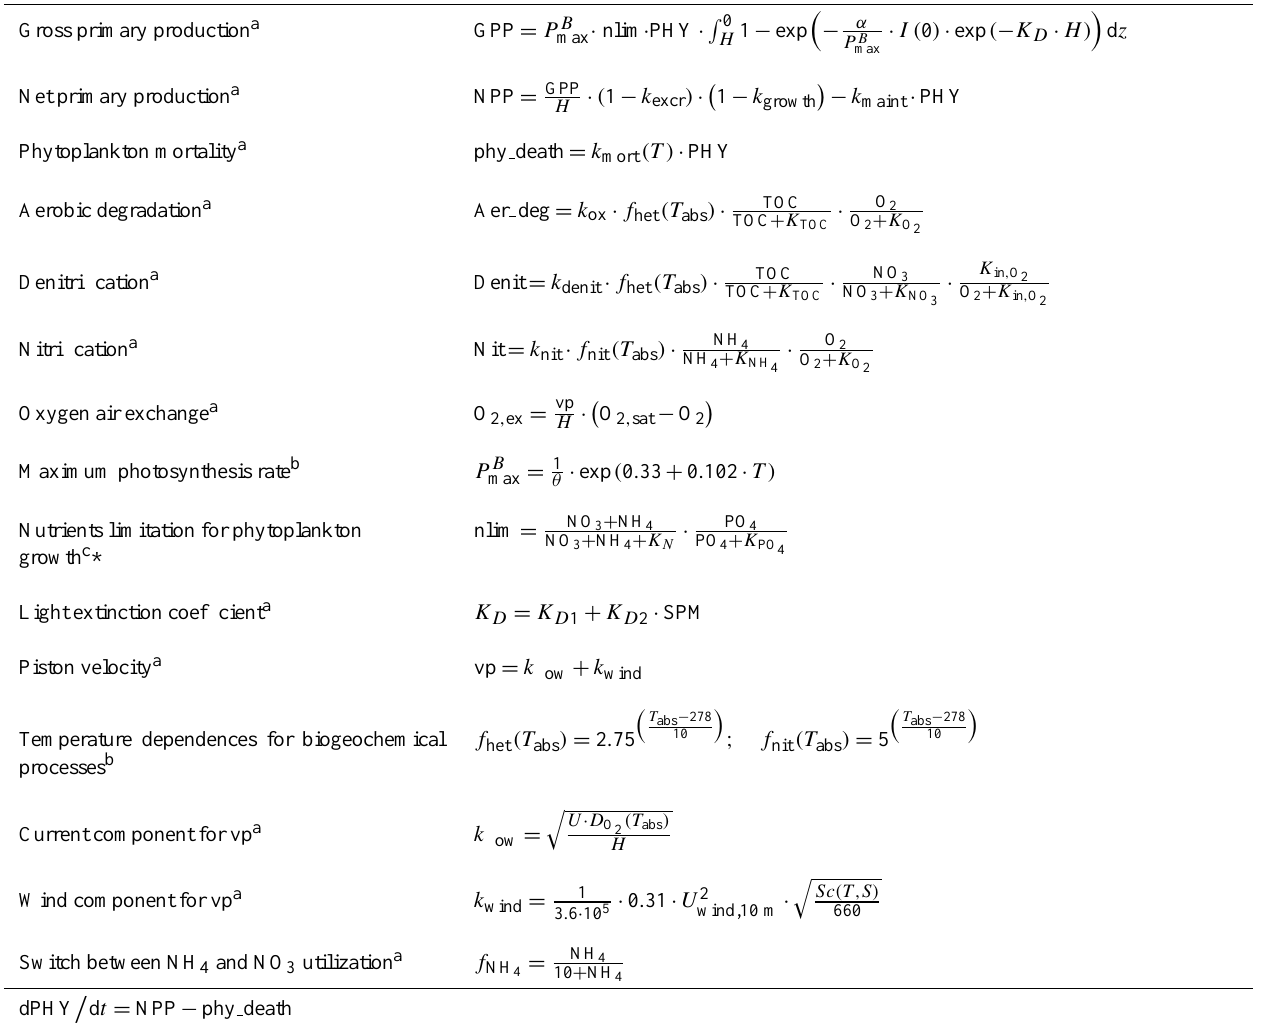
Table 1. Biological formulations and stoichiometric equations used in the C-GEM biogeochemical reaction network. T abs and T denote the absolute and Celsius temperature, respectively, and H is the water depth, a Vanderborght et al. (2007), b Arndt et al. (2009), c Garnier et al. (1995). * If PHY = DIA, nlim needs to account for the silica limitation in the phytoplankton growth. Gross primary production